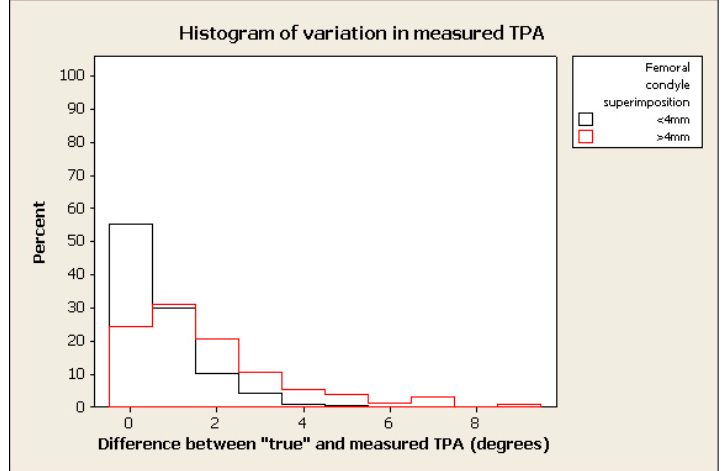
Figure 6. Histogram of % of frequency of measurements of TPA measured with femoral superimposition with <4 mm in difference between “true” and measured TPA in black and >4 mm in red.